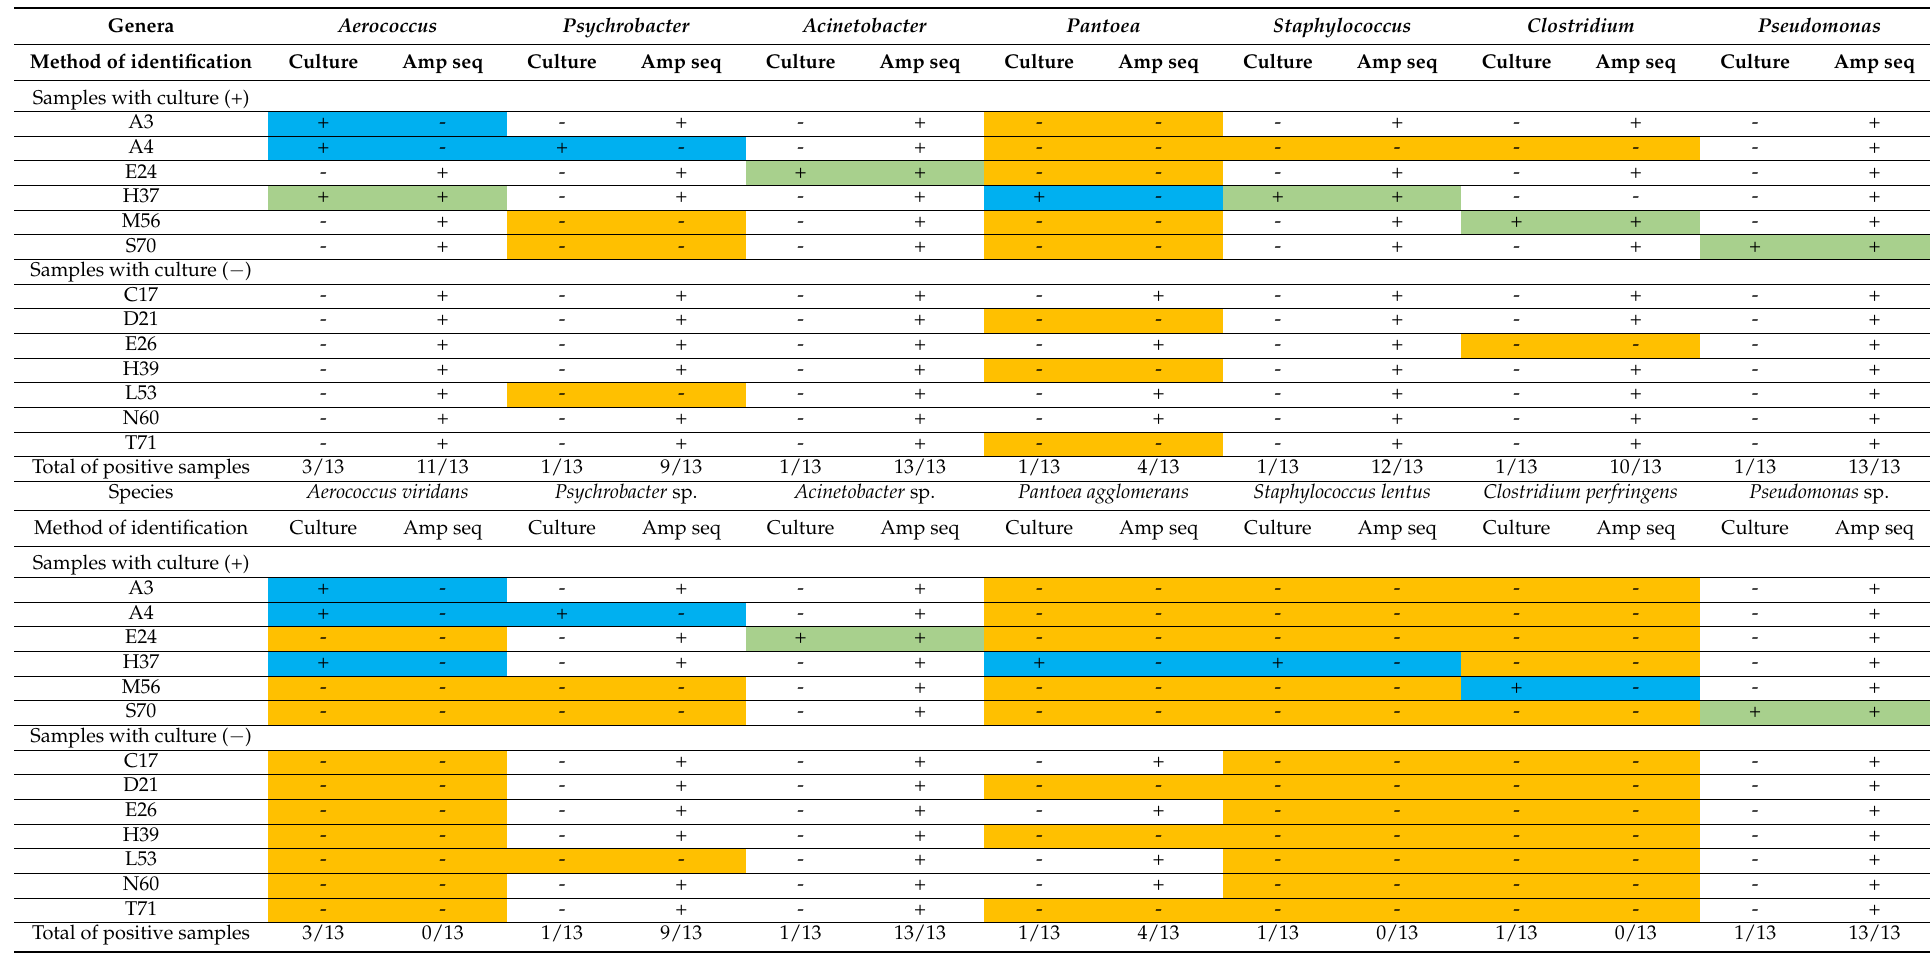
Table 1. Comparison between the result of culture and amplicon sequencing (genera and species) in the samples showing positive and negative bacterial